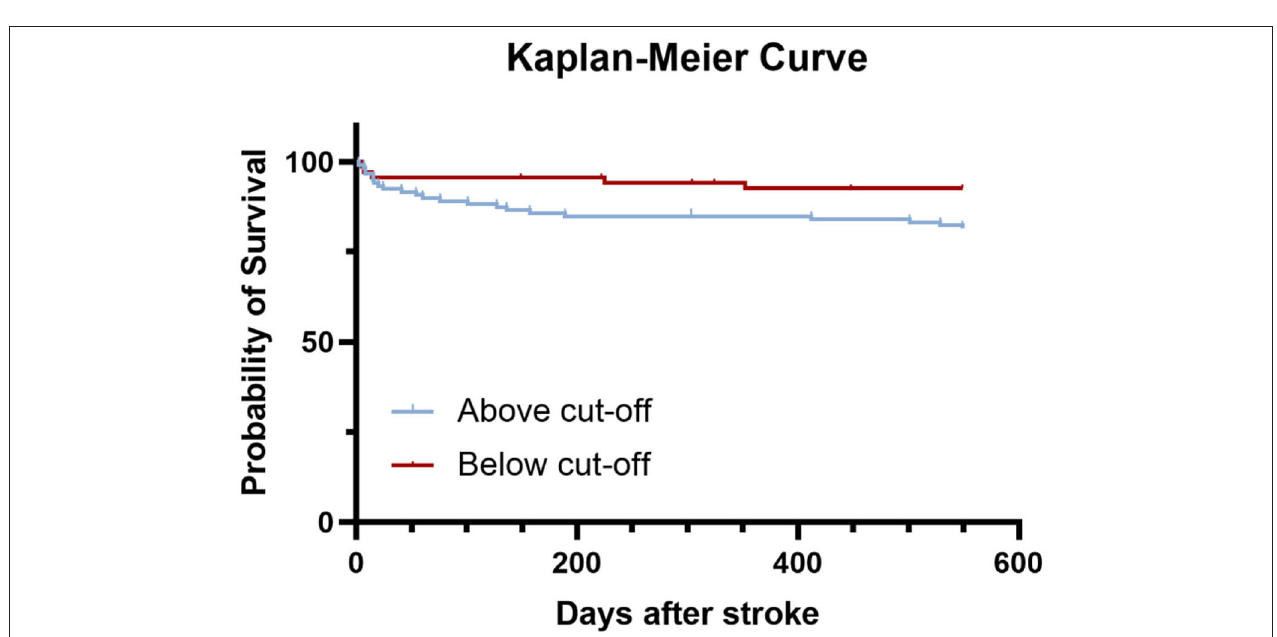
FIGURE 4 | Kaplan–Meier curves estimated survival up to 18 months (549 days) after stroke. Log rank test, P = 0.042.